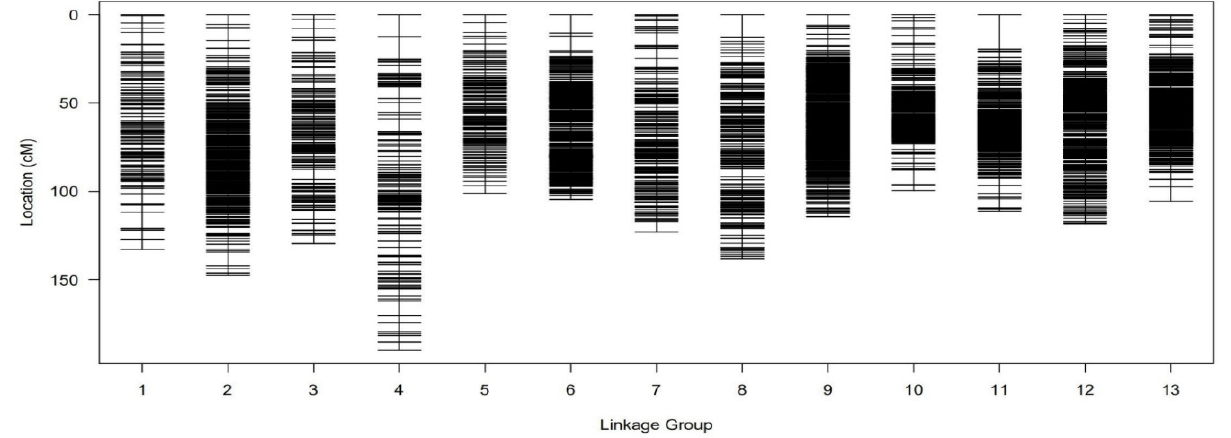
Figure 3. Distribution of SNP markers on the 13 linkage groups of Paphiopedilum . The female and male maps were also constructed in the current study. The total number of markers used for female and male maps were 5498 and 3173, respectively (Tables 5, S7 and S8, Figures S2 and S3). The total genetic lengths of female and male maps were 1994.90 cM and 1670.55 cM, respectively, with average distances between adjacent markers in the female and male maps of 0.36 cM and 0.53 cM, respectively (Table 5). Some significant differences were also observed in some LGs, for example, the markers of LG1, LG4, LG6, LG10, and LG12 in the female map were much less than those in the male map. However, the markers of LG3, LG5, LG7, LG8, LG9, LG11, and LG13 in the female map were much more than those in the male